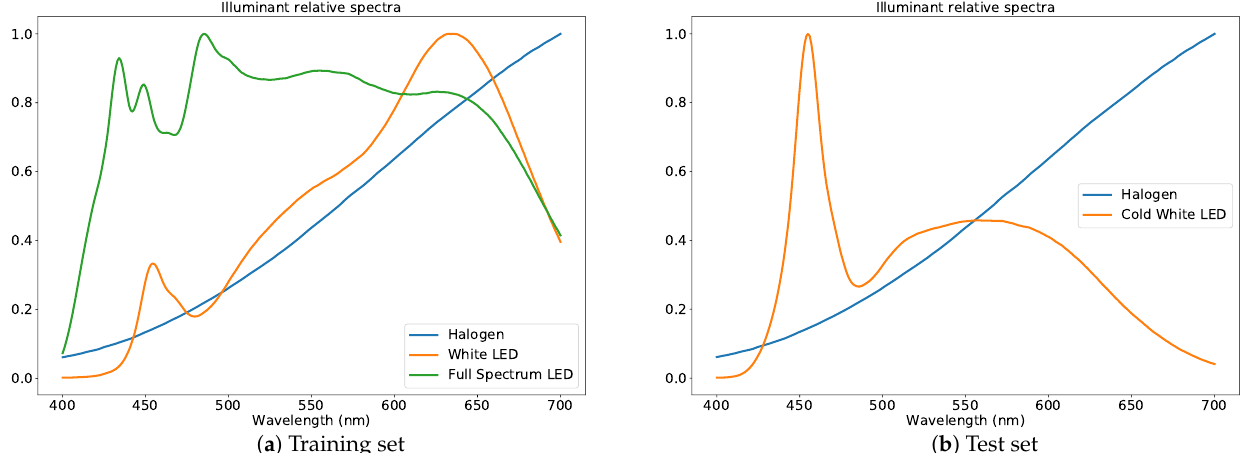
Figure 5. Relative spectra of the illuminants used in capturing diffraction images for the training and test set,